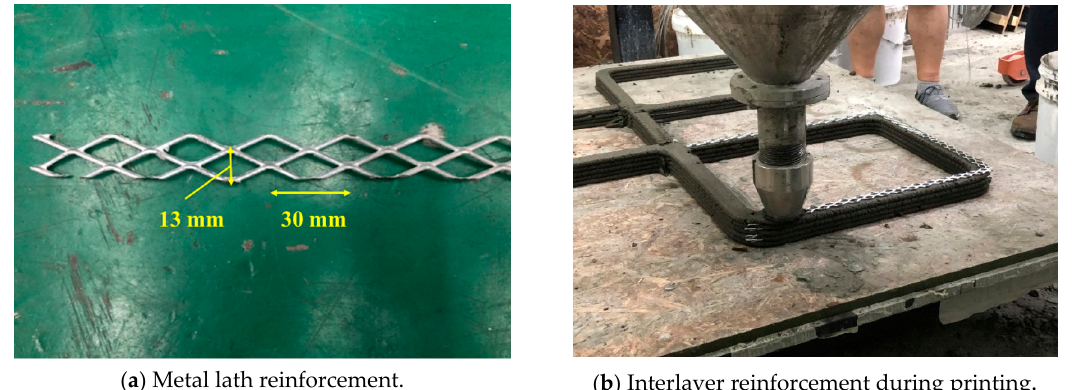
Figure 4. Interlayer reinforcement from metal laths (Structure S10).